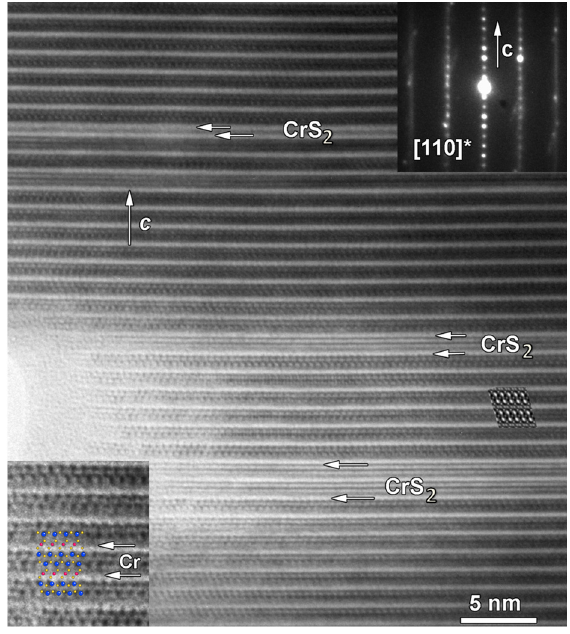
Figure 8. High-resolution transmission electron microscopy (HRTEM) image of (LaS) 1.2 CrS 2 and corresponding electron diffraction pattern. The structural model superimposed on the enlarged HRTEM image is given as inset in the bottom-left corner of the figure. La, Cr, and S are represented by blue, red, and yellow, respectively. White arrows indicate stacking faults/defects (taken with permission from reference